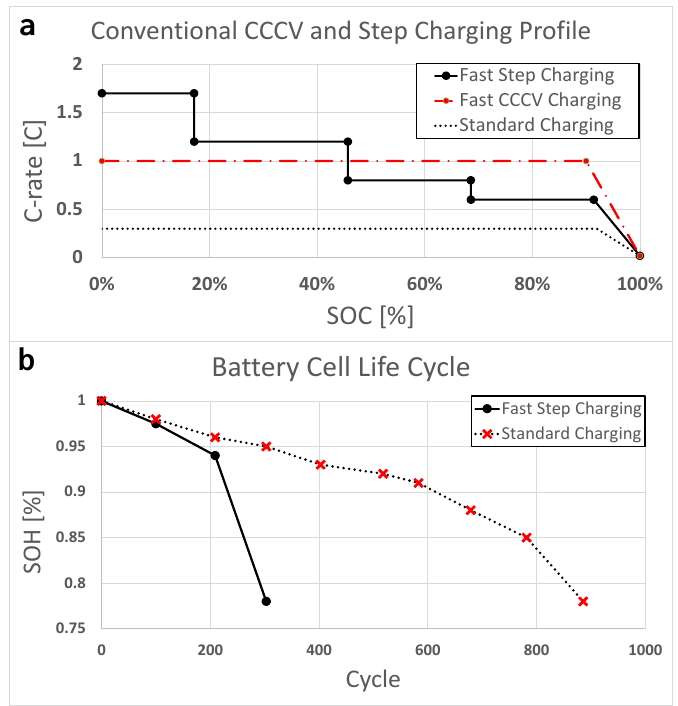
Figure 1. Current pattern examples. Results from cycle life evaluations for ( a ) a conventional charging profile according to the charging method; and ( b ) a battery cell life cycle according the charging method.